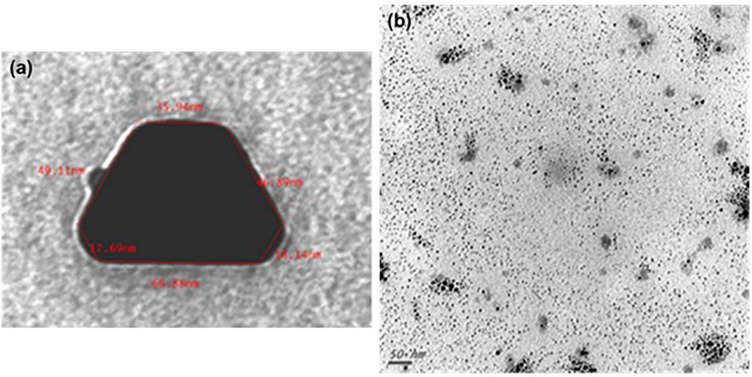
Transmission electron microscopy of SUNCs. SUNCs were electrochemically synthesized in ultrapure water. Large non-spherical nanocluster before filtration. Magnification: 250,000× (a); ultra-nanoclusters after filtration. A drop of 1:5 diluted stock solution of SUNCs was allowed to evaporate onto 300 mesh formvar-coated nickel grids, and then TEM image was taken at 75 kV by a ZEISS 109 microscope. Scale bar: 50 nm. Magnification: 85,000× (b).